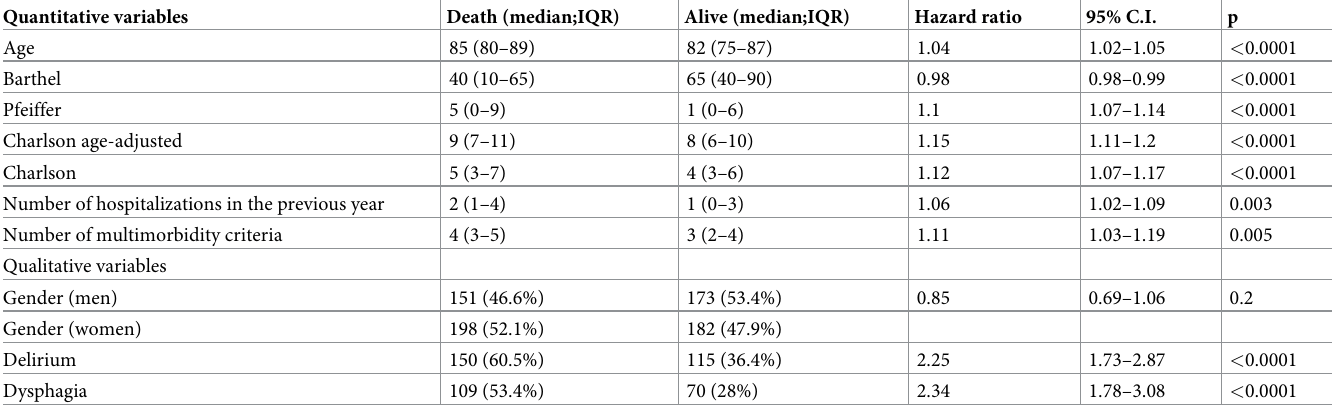
Table 3. Univariate predictors of 1-year